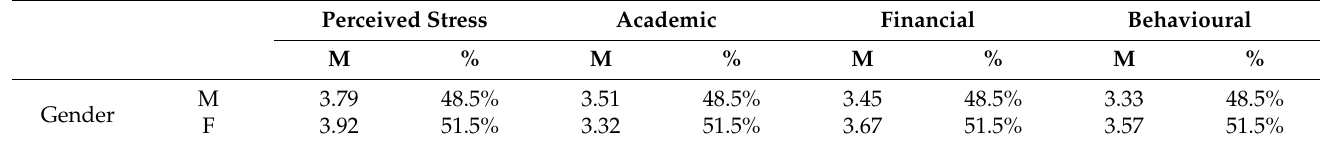
Table 4. Perceived stress and stressors score by gender .